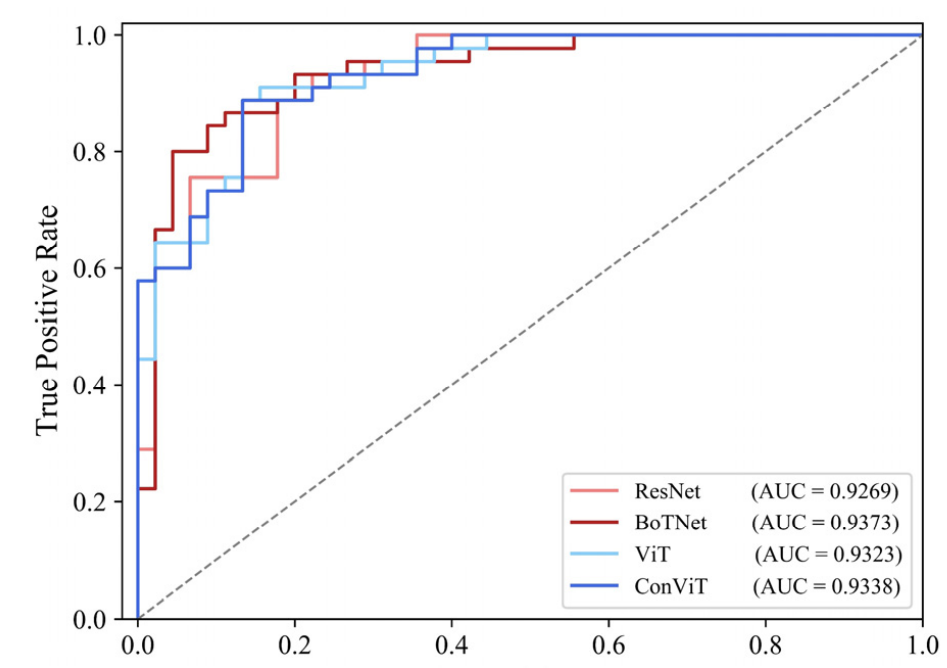
Figure 8. ROC curve of different LSM models based on the testing dataset. Table 4. Hyperparameter settings of models for LSM.